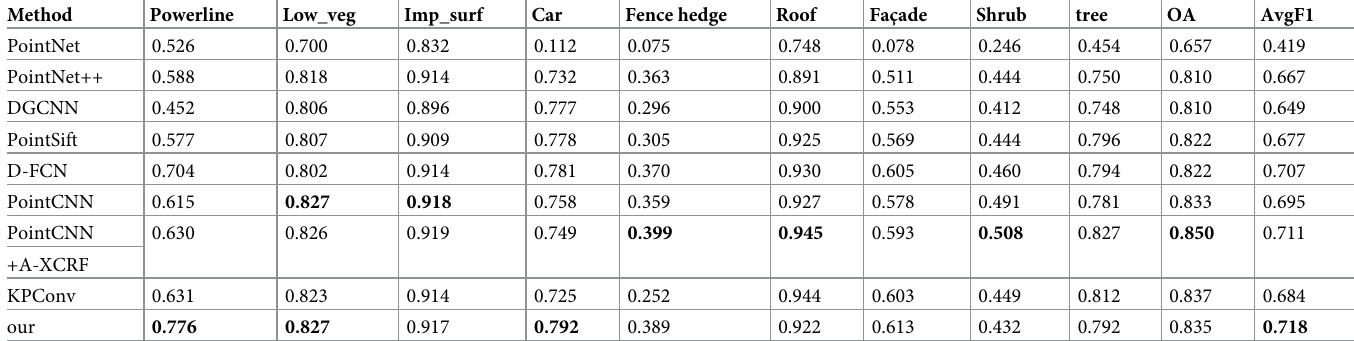
Table 6. Performance comparison between our proposed method and other state-of-art supervised models on the ISPRS Vaihingen test dataset. The first nine col- umns in the table are the per-category F1 scores, and the last two columns are the OA and AvgF1. Method